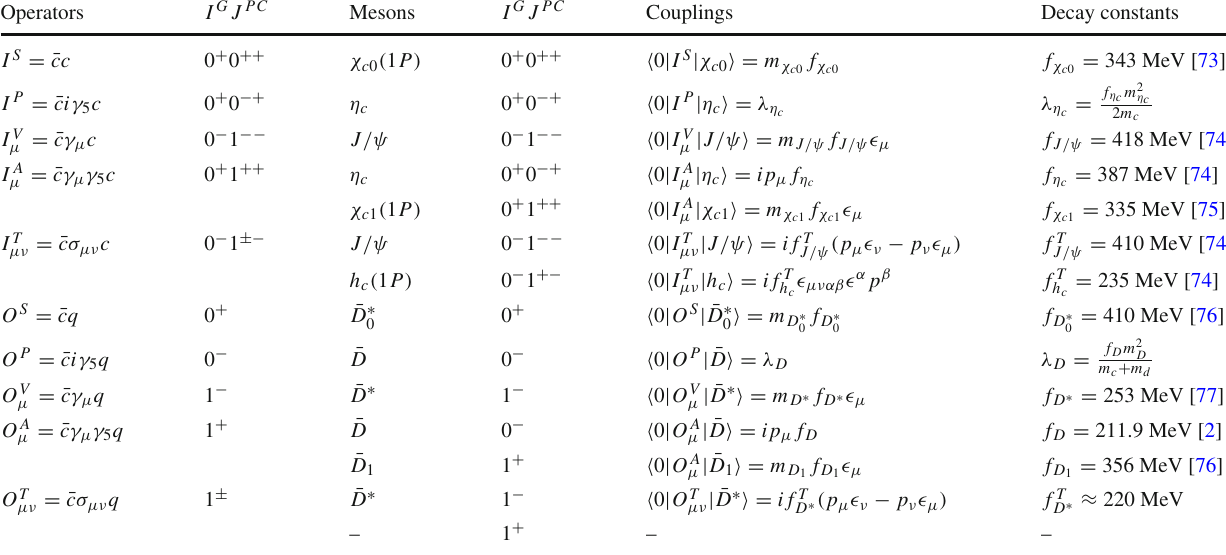
Table 1 Couplings of meson operators to meson states, where color indices are omitted for simplicity. Taken from Ref. [57] Operators I G J PC Mesons I G J PC Couplings Decay